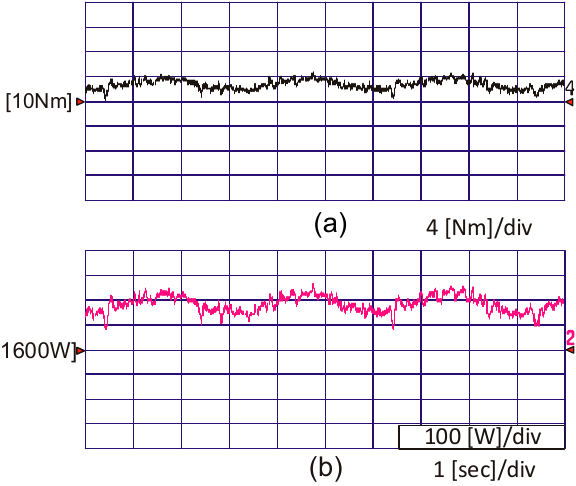
Figure 17. Tower shadow and shear effects: ( a ) Generator torque (Nm), ( b ) generator power (kW).